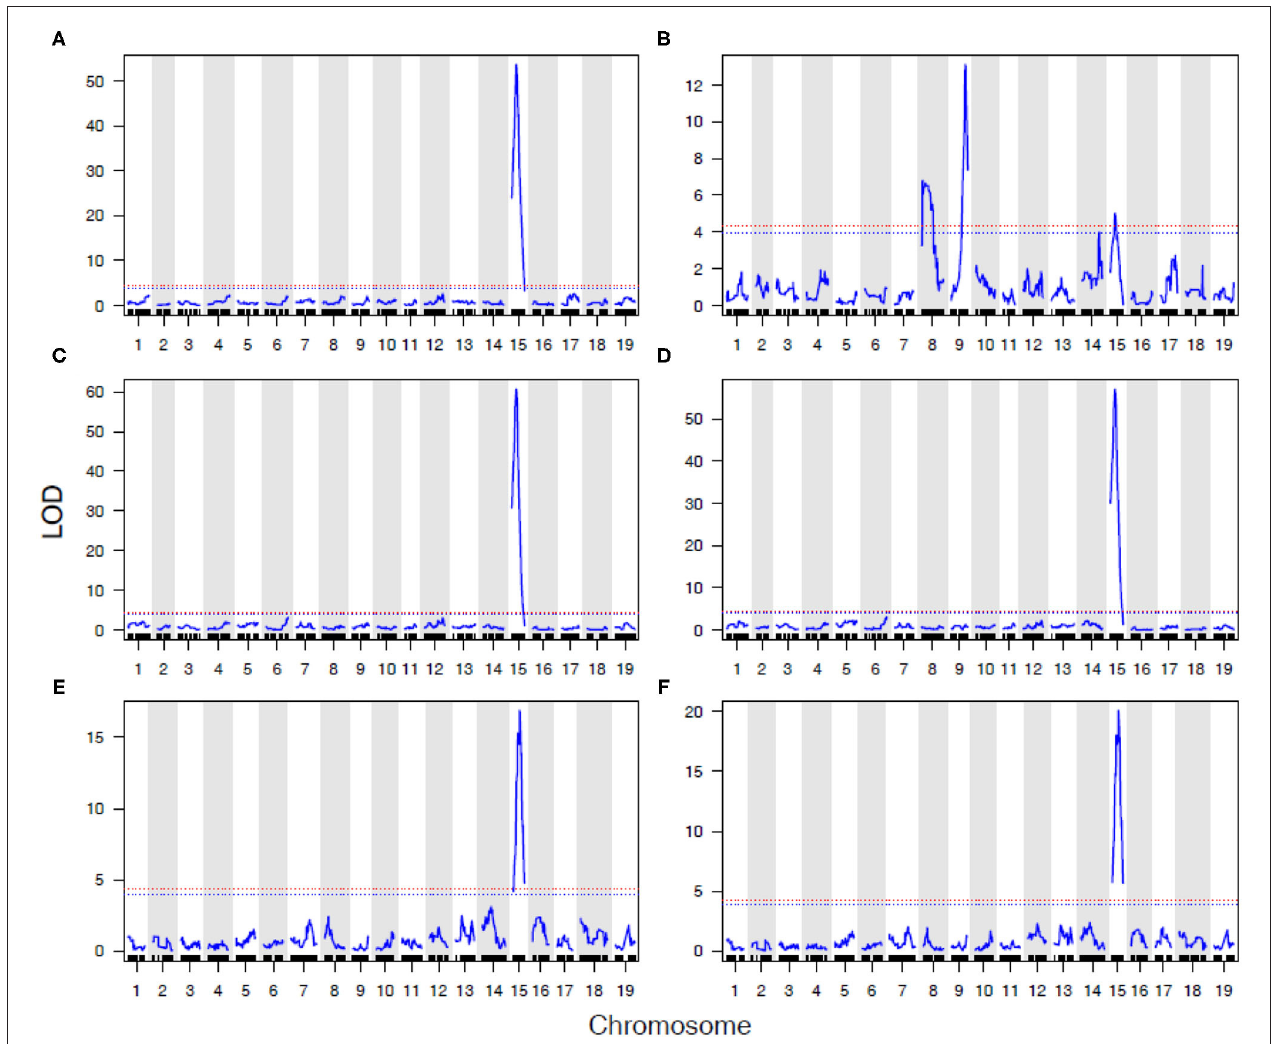
FIGURE 5 | Powdery mildew resistance on four grapevine tissues repeatedly maps to REN11 on Chr 15, except for a more complex genetic basis on B37-28 stems. Data for (A–D) B37-28 × C56-11 are based on AUDPC BLUEs for 2016 and 2017 combined, and for (E,F) Tamiami × Solbrio are based on 2017 AUDPC data. Tissues rated are: (A,E) leaf; (B,F) stem; (C) berry; (D) rachis. The 95% confidence threshold for the LOD score is based on permutation tests and is presented as a horizontal red dashed